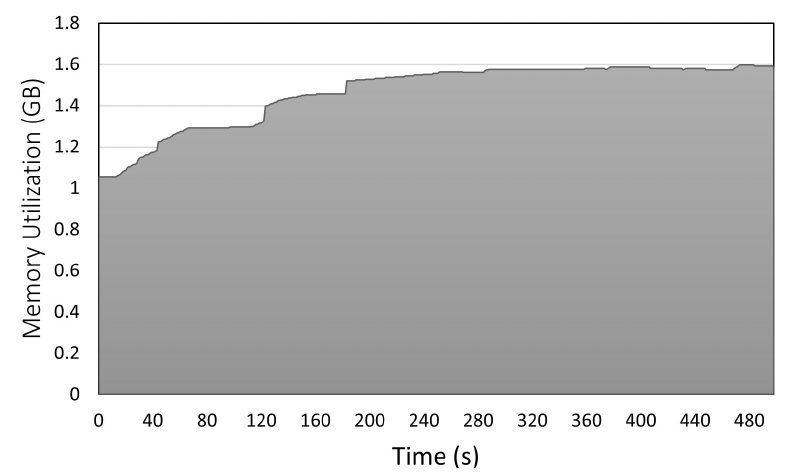
Figure 8. IASE RAM utilization over time.